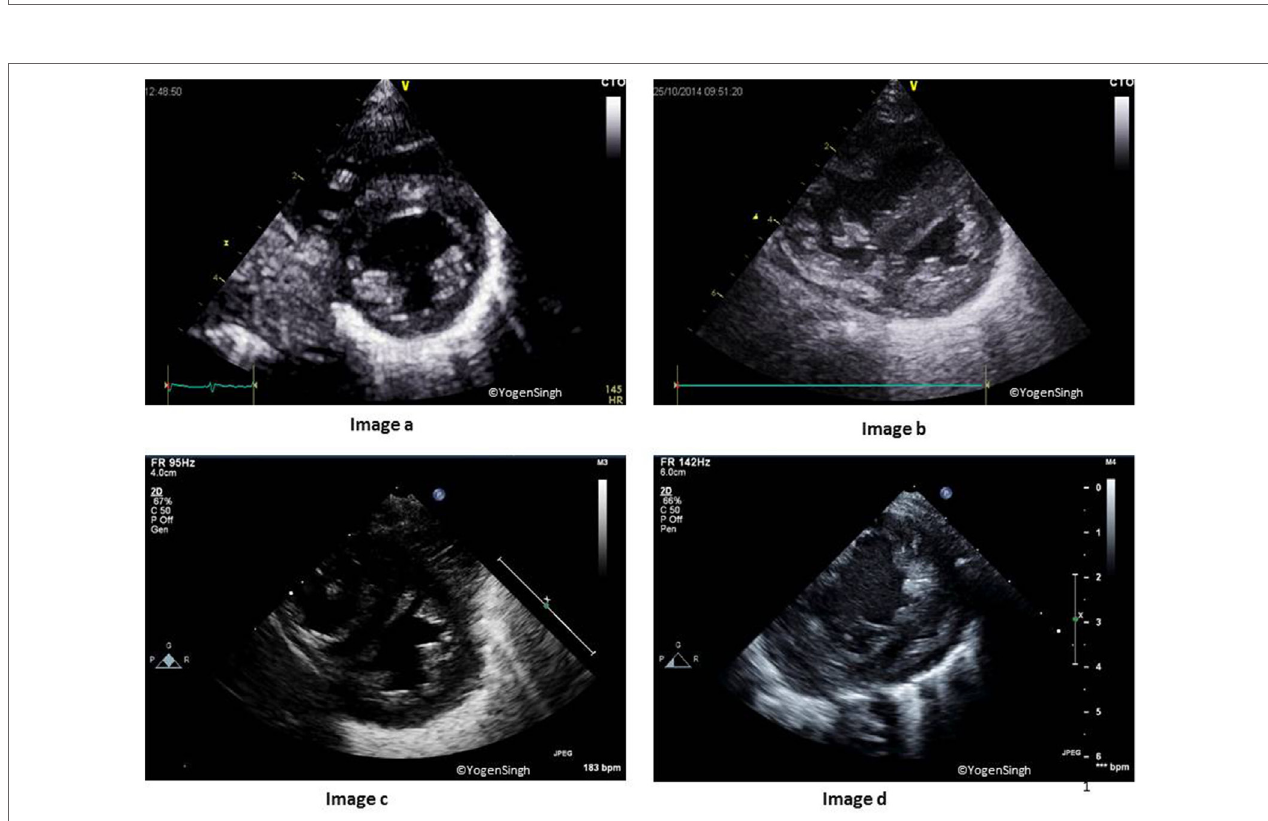
FiGURe 7 | Interventricular septum (IVS) and left ventricle (LV) shapes in pulmonary hypertension. Image a shows normal IVS and LV shape with LV being a circular-shaped structure on sweep PSAX view. Images b–d show change in shapes with increasing flattening of IVS in presence of mild, moderate, and severe pulmonary hypertension, respectively.